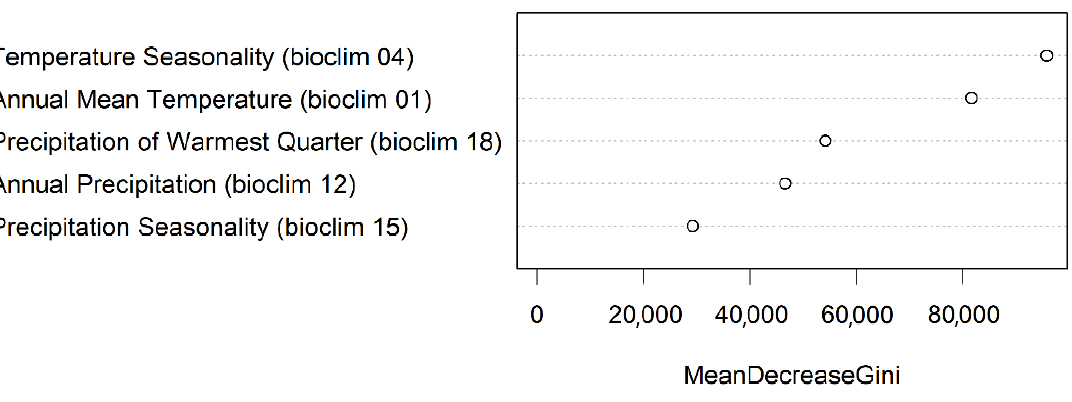
Figure 3. Variable importance of the fitted random forest model (mean decrease Gini) across all 29 vegetation classes.